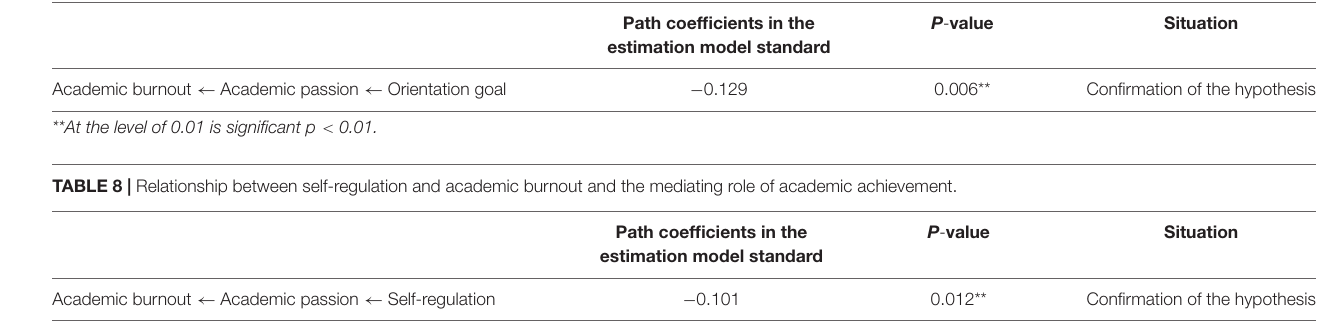
TABLE 7 | Relationship between goal orientation and academic burnout with the mediating role of academic motivation.